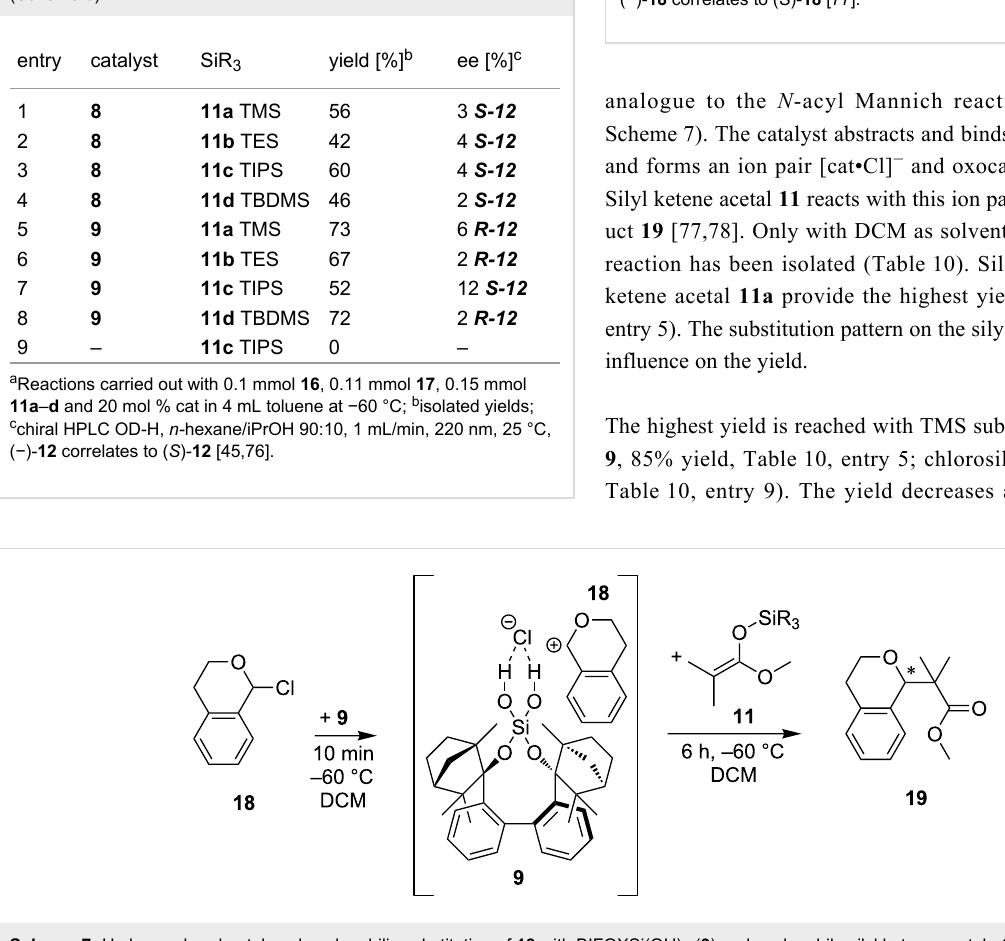
Scheme 7: Hydrogen-bond-catalyzed nucleophilic substitution of 18 with BIFOXSi(OH) 2 ( 9 ) and nucleophile silyl ketene acetals 11 . 18 and 9 form an activated electrophile ion pair complex which yields C–C coupling product 19 (Table 10).